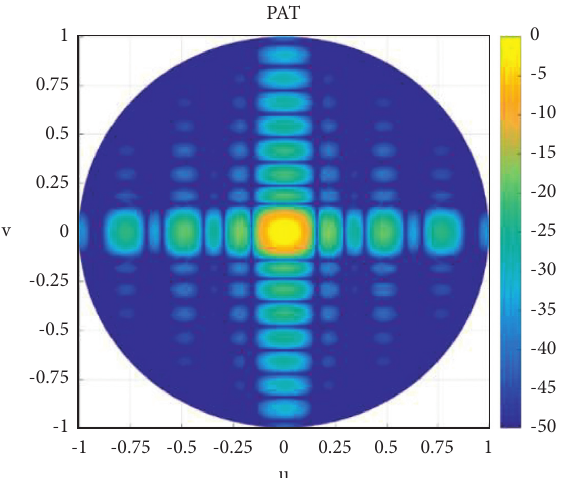
Figure 8: Change of the position error pattern of the left and right half arrays in the X -direction ( 0 . 2 λ ) .